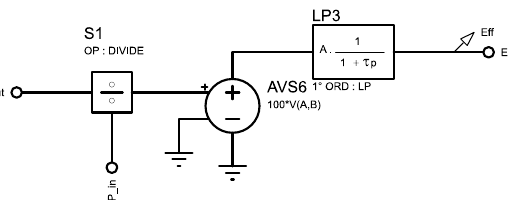
Figure 9. Efficiency determination using divider function, arbitrary voltage control voltage source and the Laplace first-order low-pass filter transfer function.